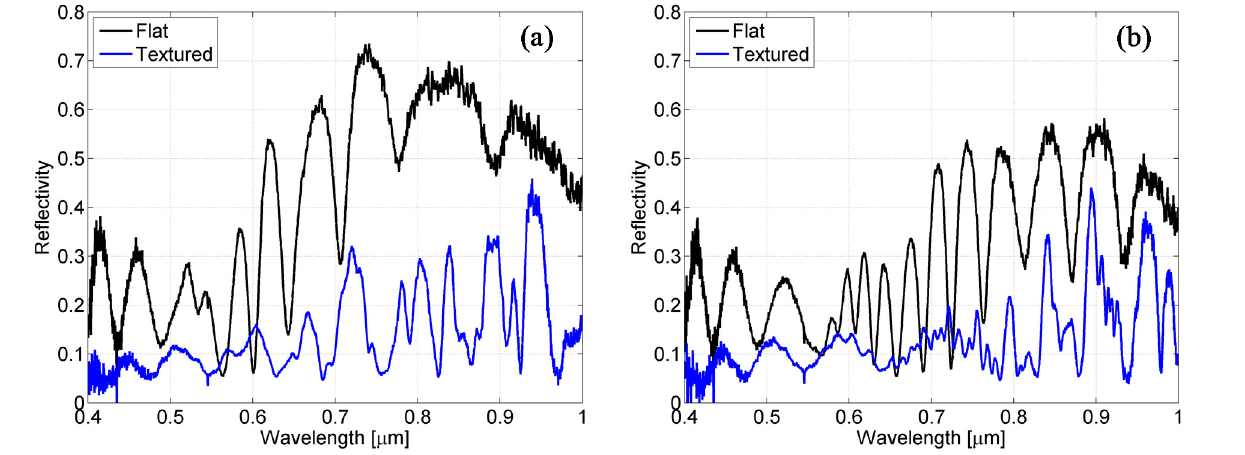
Figure 7. Optical characterization of the solar cells, with reflectance spectra for the flat superstrate (solid black line) and textured superstrate (solid blue line) with Si layer thickness of 800 nm ( a ) and 1500 nm ( b